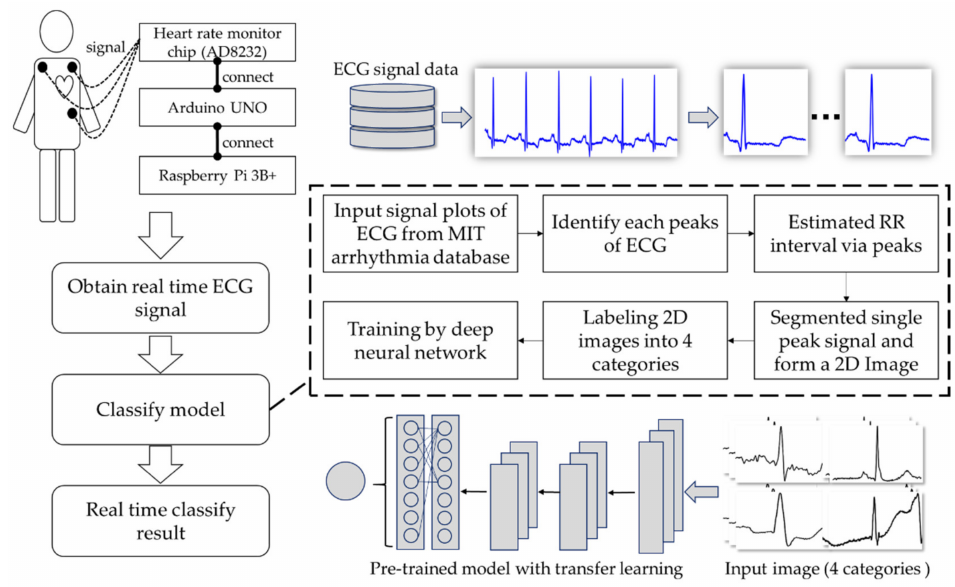
Figure 1. Research structure of the proposed